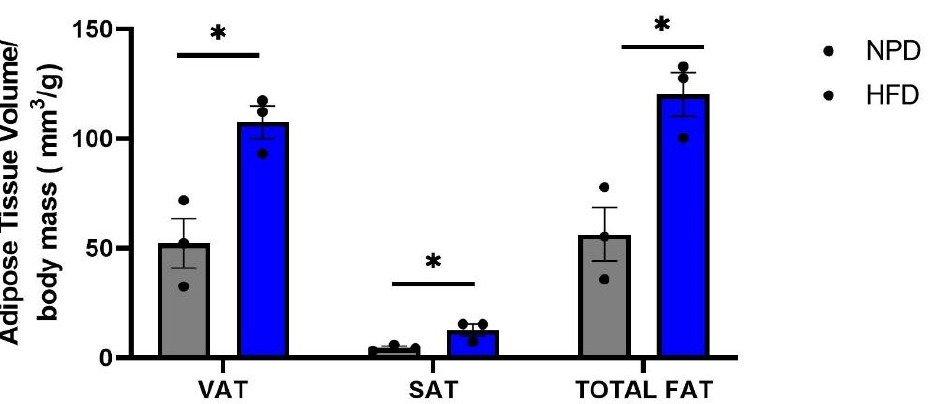
Figure 4. Transverse micro-CT quantification. Visceral adipose tissue (VAT), subcutaneous adipose tissue (SAT) and total adipose abdominal tissue (Total FAT) expressed relative to body mass in NPD and HFD rats. Data are the means ± S.E.M. Statistical significance indicated for (*) p <